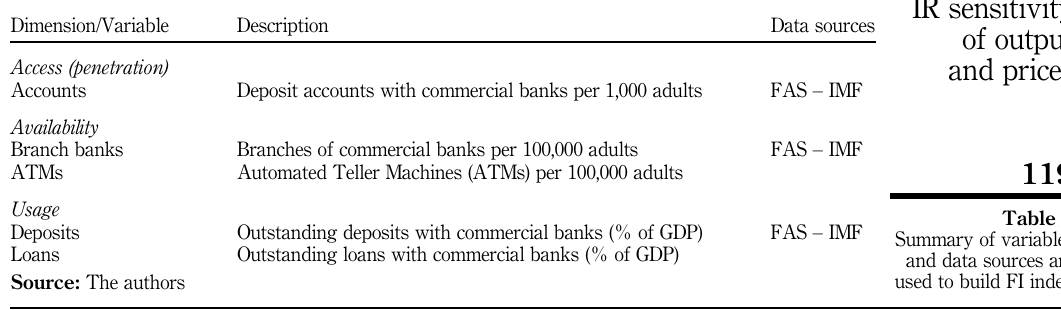
Table I. Summary of variables